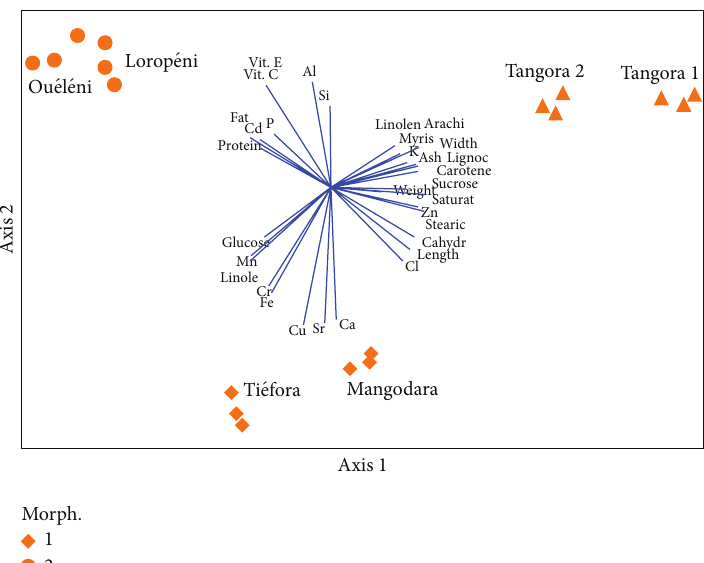
Figure 2: Ordination of the Burkina Faso Cyperus esculentus tubers showing three morphotypes. Myris = myristic acid, Stearic = stearic acid, Arachi = arachidic acid, Lignoc = lignoceric acid, Saturat = total saturated acids, Linole = linoleic acid, Linolen = linolenic acid, Cahydr = carbohydrates, Vit. C = vitamin C, and Vit. E = vitamin E.